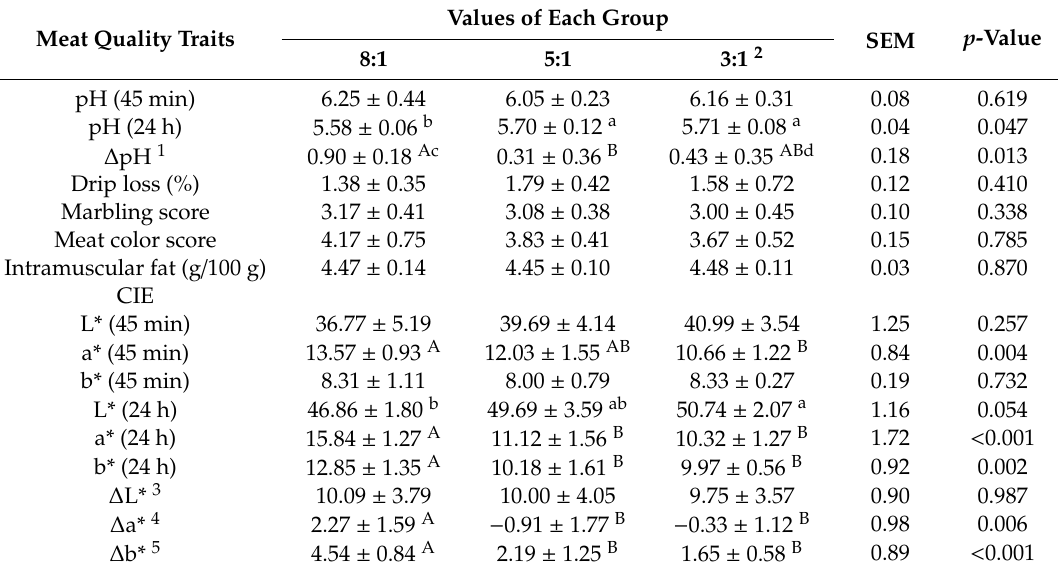
Table 4. E ff ects of dietary n-6 / n-3 PUFA ratio on the meat quality of Heigai pigs Meat Quality